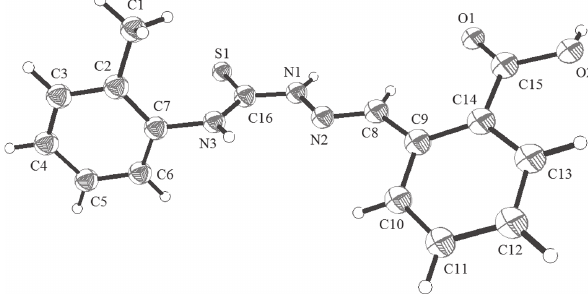
Table 1: Data collection and handling.